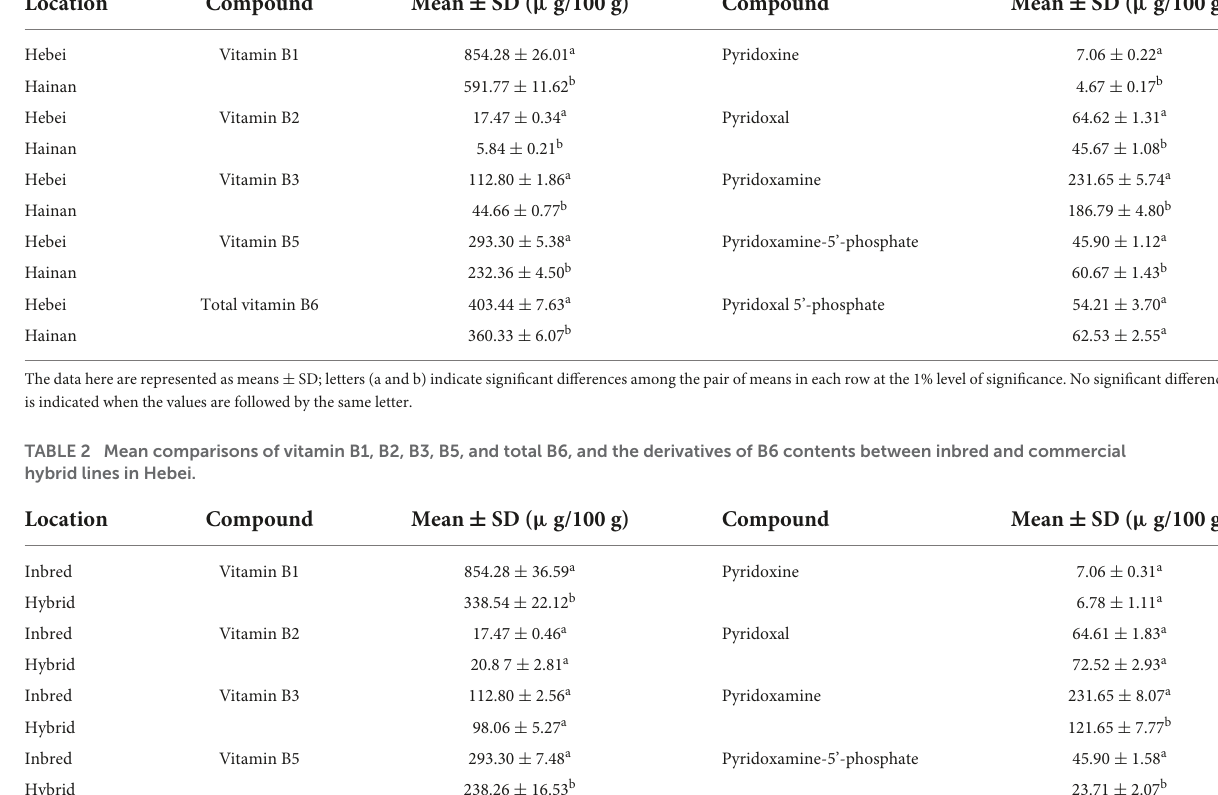
TABLE 1 Mean comparisons of vitamin B1, B2, B3, B5, and total B6, and the derivatives of B6 contents among inbred lines of Hainan and Hebei grain. Location